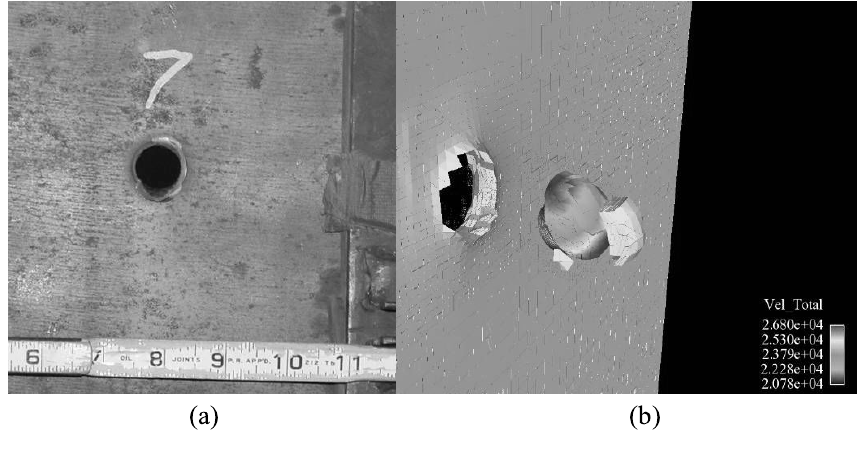
Fig. 7. Damage to the 6.35 mm plate (a) experiment and (b)